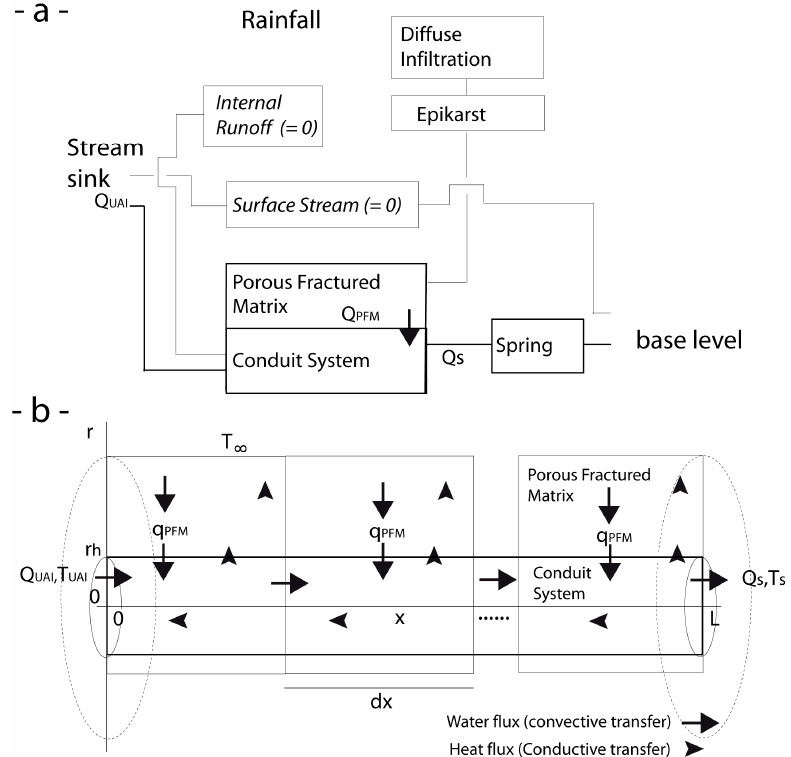
Figure 3. ( a ) Conceptual fluviokarst redrawn from White [31,32] but restricted to recession period (neither runoff nor surface flow). The karstic aquifer is embedded in a saturated PFM drained by a CS that gathers inflows. Outflow discharges at the base level of the neighbor stream through a spring (or pump). The hydrological system includes an upper allogenic stream, which flow joins the CS through a swallow zone. The CS also receives PFM, diffuse flow through an epikarstic layer; ( b ) An OTS is surrounded by pervious boundaries bounding the CV. Water and thermal energy inputs come from the allogenic streams and PFM. Outputs leave the CS through a spring (or pump). During recession no reverse flow occurs from CS to PFM.